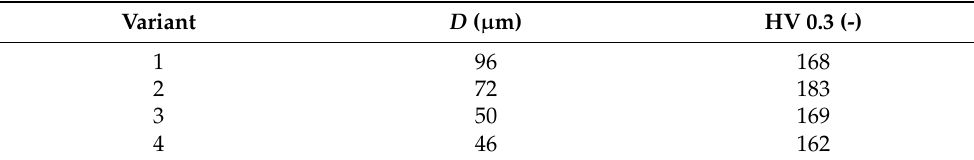
Table 7. Average austenitic grain size values before phase transformation and average microhard- ness